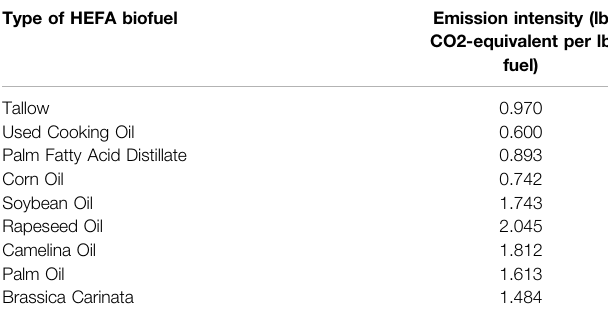
TABLE 1 | Types of HEFA biofuel and their emission